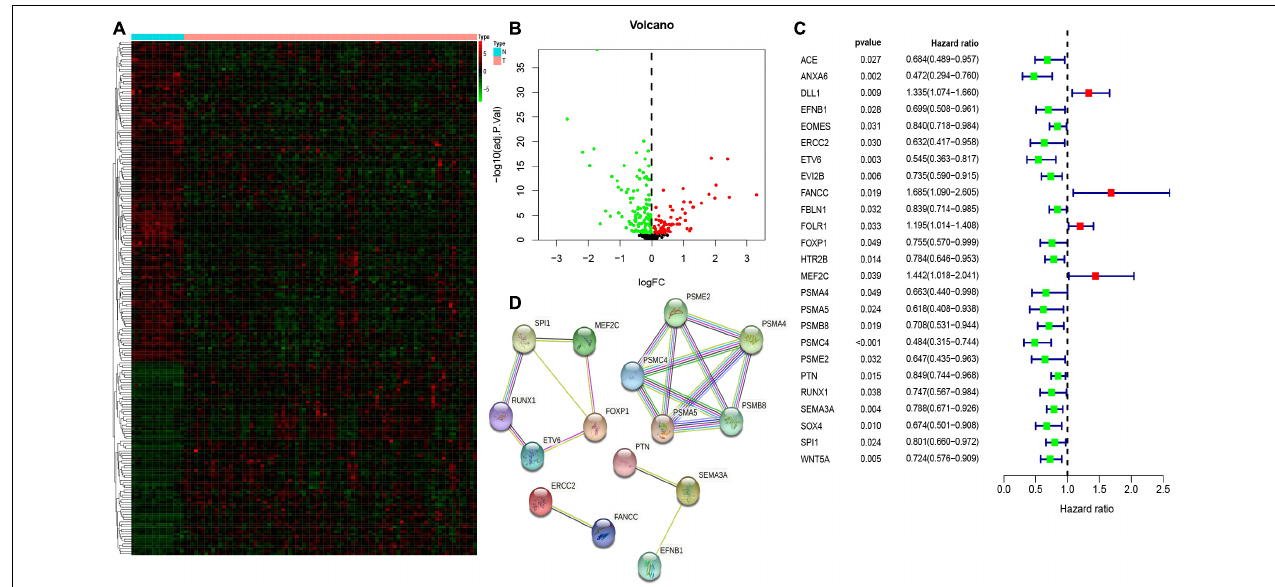
FIGURE 2 | The heatmap (A) and volcano (B) of differentially expressed genes (DEGs) between osteosarcoma and normal tissues/cells. The univariate Cox regression analysis of 25 prognostic stem cell-related DEGs (C) . The protein–protein interaction (PPI) network showed the interactions of 25 prognostic stem cell-related DEGs (D) .